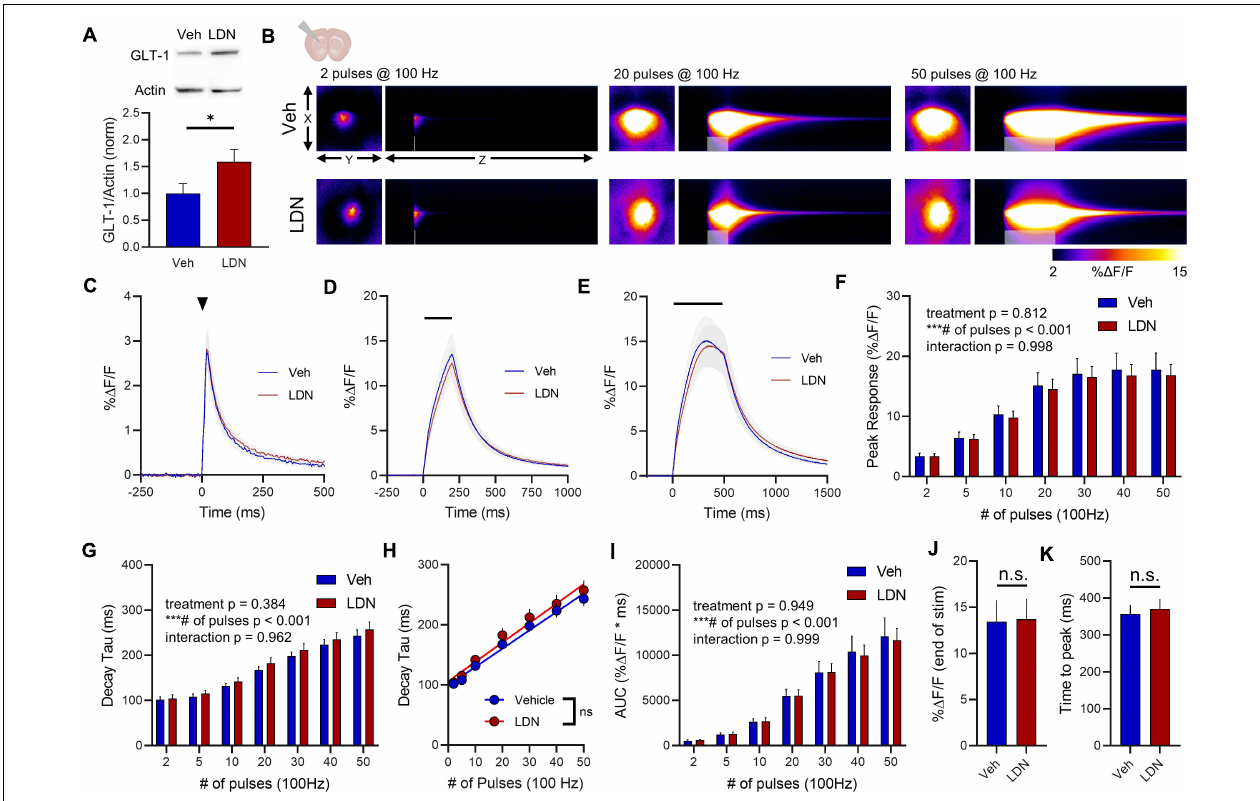
FIGURE 7 | The effect of LDN on glutamate dynamics in the striatum. (A) GLT-1 expression in striatal tissue from vehicle (Veh)- and LDN-treated mice. (B) Representative images depicting the iGluSnFR response evoked by 2 (left), 20 (middle), and 50 (right) pulses of electrical stimulation at 100 Hz in Veh- (top) and LDN-treated (bottom) mice. X–Y images (2048 × 2048 µ m) depict the maximal projection image of the iGluSnFR response, while the X–Z image (2048 µ m vertically x 1945 ms horizontally) depicts the iGluSnFR response over time (z-axis). Gray shading indicates the onset and duration of electrical stimulation at 100 Hz. (C–E) Mean ( ± S.E.M in gray) iGluSnFR responses to 2 (C) , 20 (D) , and 50 (E) pulses at 100 Hz in Veh- and LDN-treated mice. Electrical stimulation is denoted by the arrowhead in (C) and the horizontal lines in (D) and (E) . (F) Mean ( ± S.E.M) iGluSnFR response peaks. (G) Mean ( ± S.E.M) iGluSnFR decay tau values. (H) Linear regression to assess the magnitude of the activity-dependent increase in iGluSnFR decay tau. (I) Mean ( ± S.E.M) iGluSnFR area under the curve (AUC). (J) Mean ( ± S.E.M) of the iGluSnFR response size (% (cid:49) F/F) at the termination of the 50-pulse stimulation paradigm (50 pulses at 100 Hz). (K) Mean ( ± S.E.M) of the time required for the iGluSnFR response to reach a peak during the 50-pulse stimulation paradigm. ∗ p < 0.05, ∗∗∗ p < 0.001. n.s. not significant. Brain slice schematic in (B) was created using